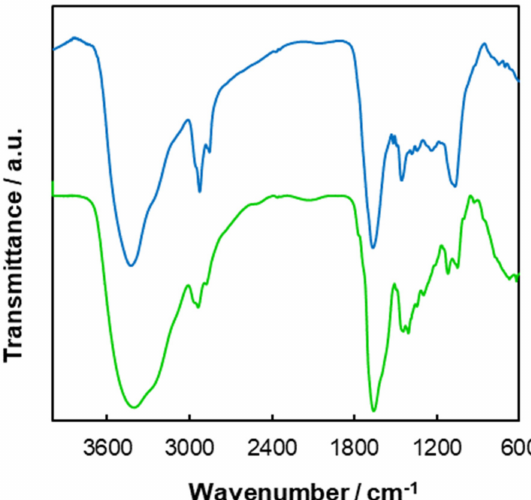
Figure 1. FTIR spectra (KBr) of C-dots from CGsSV by HTC (green line) and Mw-HTC (blue line)